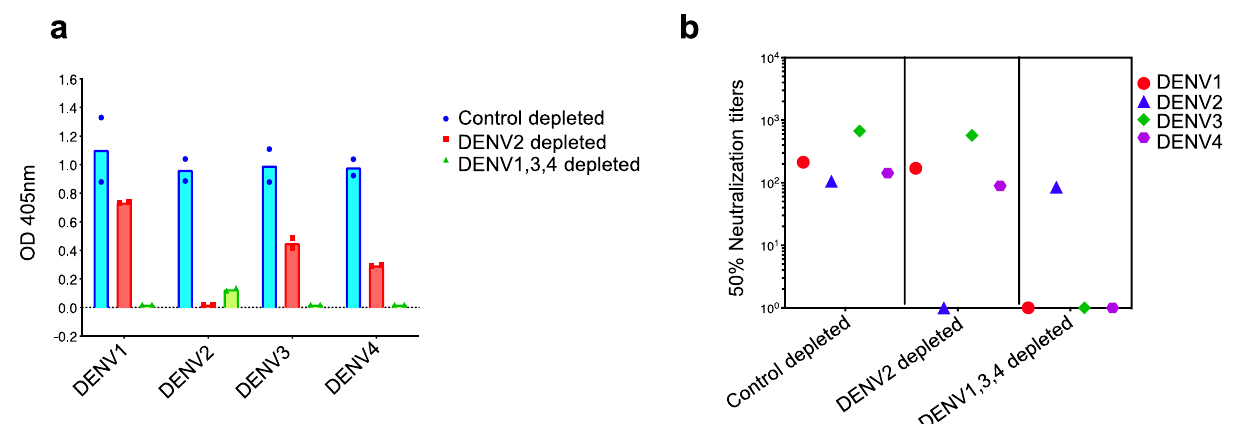
Fig. 1 DENV antibody depletion assay to estimate proportions of serotype-speci fi c and cross-reactive-neutralizing antibodies in a subject who received TV003. Subject 6 was tested 6 months after vaccination to measure levels of TS binding and neutralizing antibodies to each DENV serotype. The sample was incubated with immobilized bovine serum albumin (control depleted), DENV2 antigen (DENV2 depleted) and a mix of DENV1, 3 and 4 antigens (DENV1, 3, 4 depleted) to remove speci fi c populations of antibodies. The DENV2 depletion resulted in the removal of DENV cross-reactive and DENV2 TS antibodies, while retaining any DENV1, 3, or 4 TS antibodies in the sample. The DENV1, 3, 4 depletion resulted in the removal of DENV cross- reactive and DENV1, 3, and 4 TS antibodies, while retaining any DENV2 TS antibodies in the sample. The sample depleted of speci fi c antibody populations was tested by a ELISA to detect any DENV1, 2, 3, or 4 type speci fi c binding antibodies. Data was analyzed from subject 6 and represented as bars from a single independent experiment and expressed as mean ODs with corresponding data points shown. b Neutralization test to measure levels of TS- neutralizing antibodies to each DENV serotype. Data was analyzed from subject 6 and represented as dots from a single independent experiment and expressed as 50% neutralization